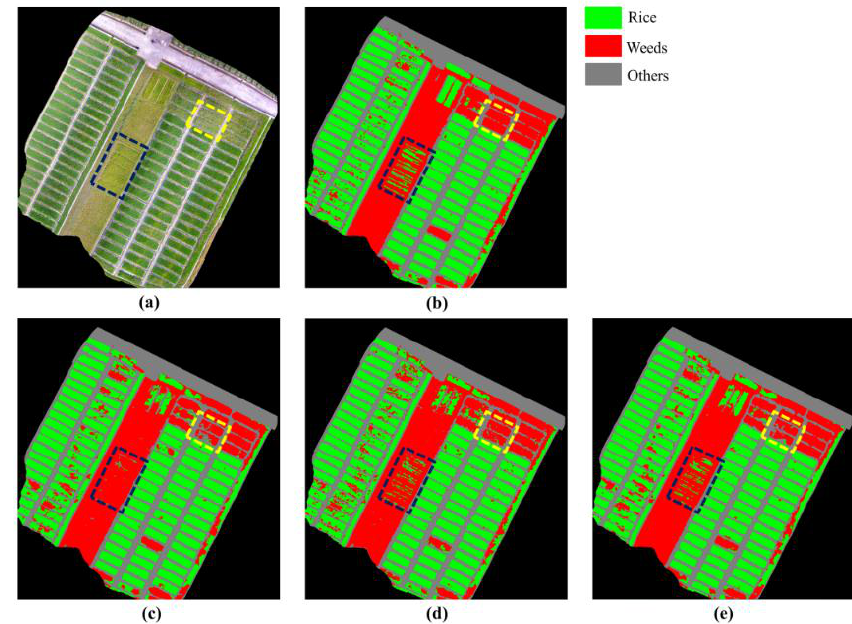
Figure 5. Weed cover maps output by different approaches. ( a ) Ortho-mosaicked imagery. ( b ) Corresponding GT-labels. The areas outside the studied plot were masked out (in black) and ignored in the training and evaluation. ( c ) Output by FCN-8s. ( d ) Output by Deeplab. ( e ) Output by